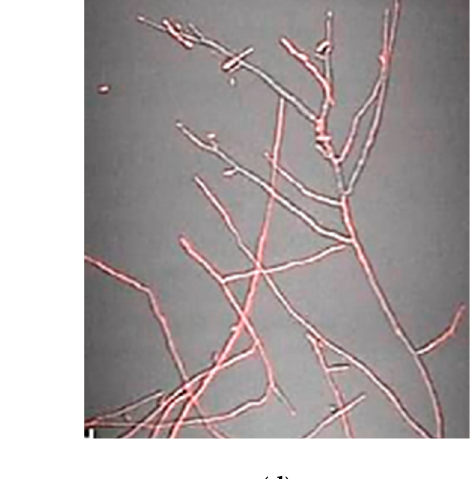
Figure 20. Comparison of ultrastructural and cell permeability changes in F. oxysporum mycelium upon chitosan bionanomaterial (BNM) exposure: ( a ) and ( c ) show ultrastructural changes determined by SEM analysis of F. oxysporum mycelium of control ( a ) and chitosan BNMs (400 µg/mL) ( c ); ( b ) and ( d ) show cell permeability analysis data by propidium iodide assay; ( b ) influx of control; ( d ) influx of chitosan BNMs treatment (modified after [84] ).